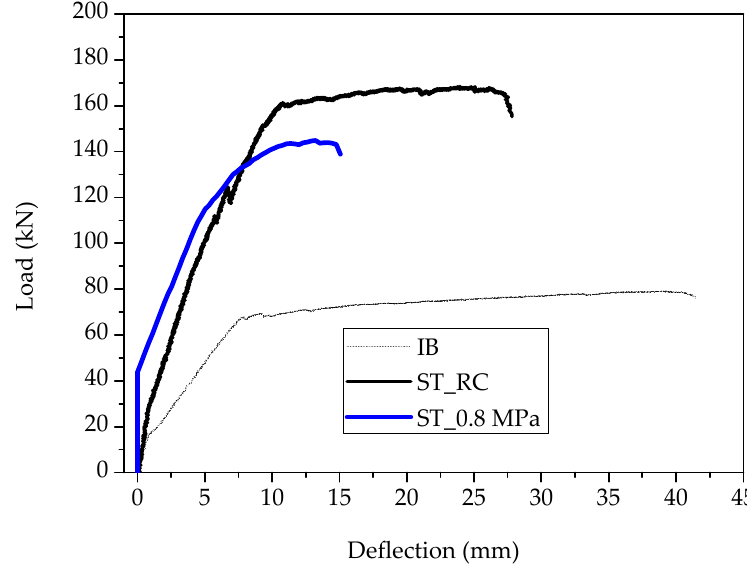
Figure 18. Load-mid span deflection results .